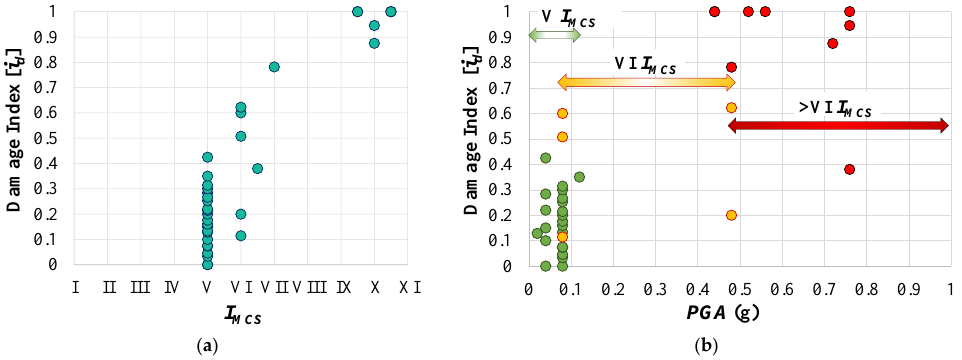
Figure 23. Damages directly observed by the authors in the churches sample compared to: ( a ) PGA (g); ( b ) macroseismic intensity, I MCS .